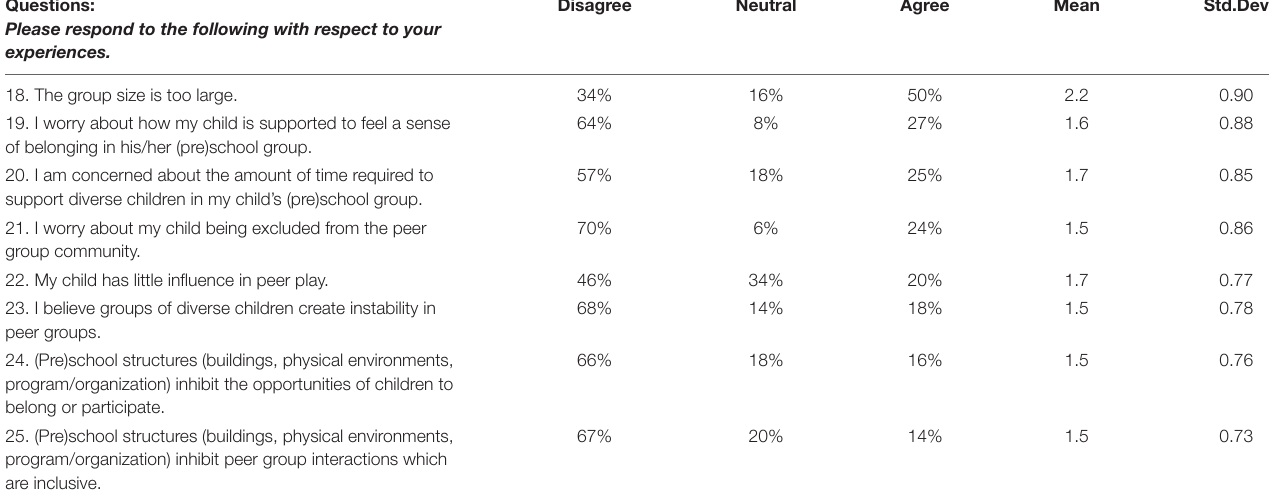
TABLE 9 | Scale 4: Parents’ concerns and criticisms for inclusion. Questions: Please respond to the following with respect to your experiences.